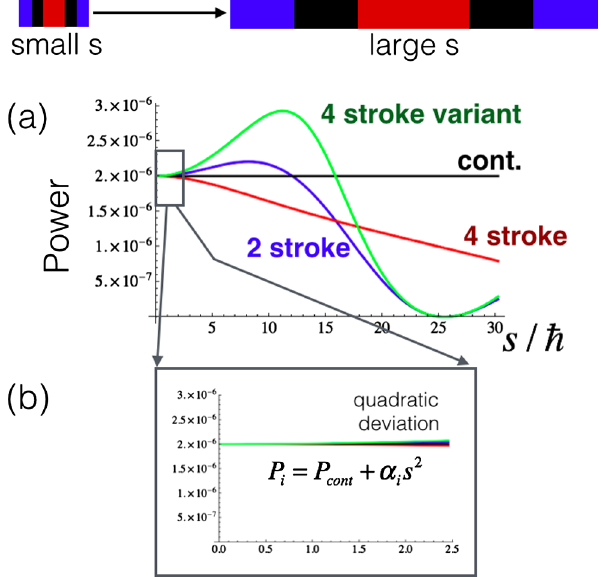
FIG. 7. Powerasafunctionofaction forvariousenginetypesina steady state. The four-stroke variant (green line) is described in Fig. 5(d). The action is increased by increasing the stroke duration (top illustration). (a) For large action with respect to ℏ , the engines significantly differ in performance. In this example, all engines have the same efficiency, but they extract different amounts of heat from the hot bath. (b) In the equivalence regimewhere the action is small, all engine types exhibit the same power and also the same heat flows. The condition s < ℏ = 2 that follows from the Strang decomposition agrees with the observed regime of equivalence. The time-symmetric structure of the engines causes the deviation from equivalence to be quadratic in the